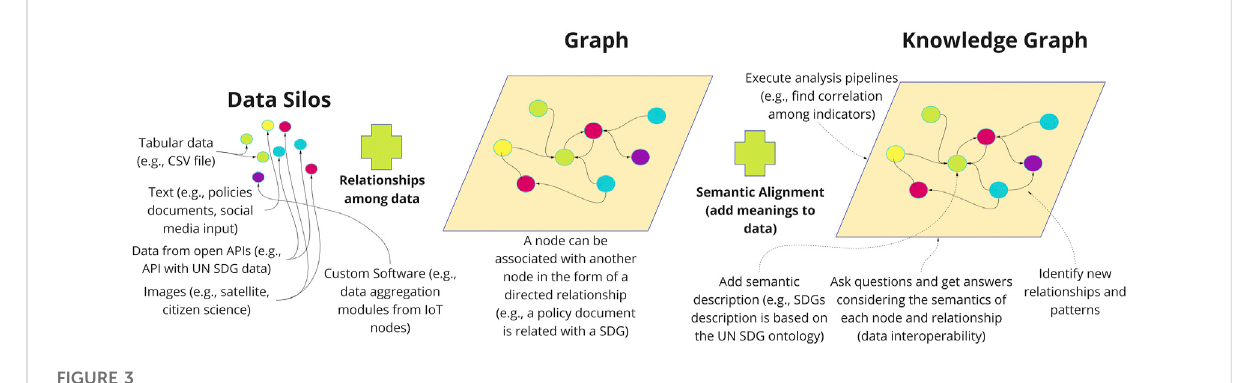
FIGURE 3 Information Management from data silos to a Knowledge